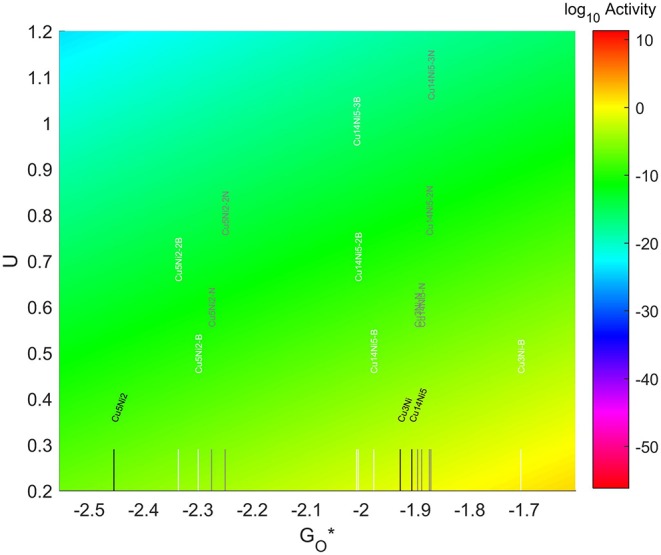
Volcano plot for ORR activity of Cu-Ni 4-atom, 7-atom, and 19-atom TMNP-doped-MDG. 4/7/19 atom systems are Cu3Ni, Cu5Ni2, and Cu14Ni5, respectively.